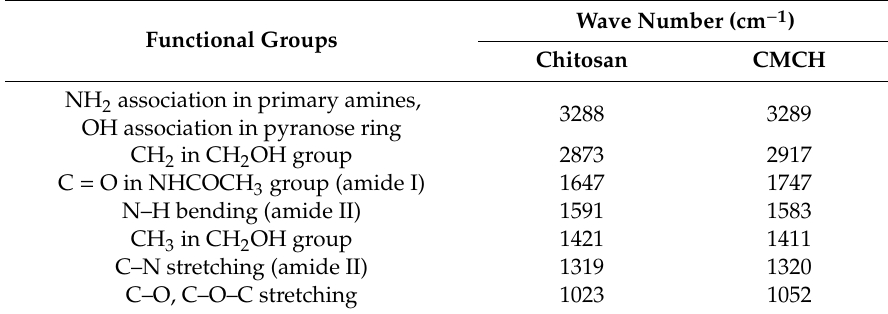
Table 2. Functional groups and wave number (cm − 1 ) of chitosan and